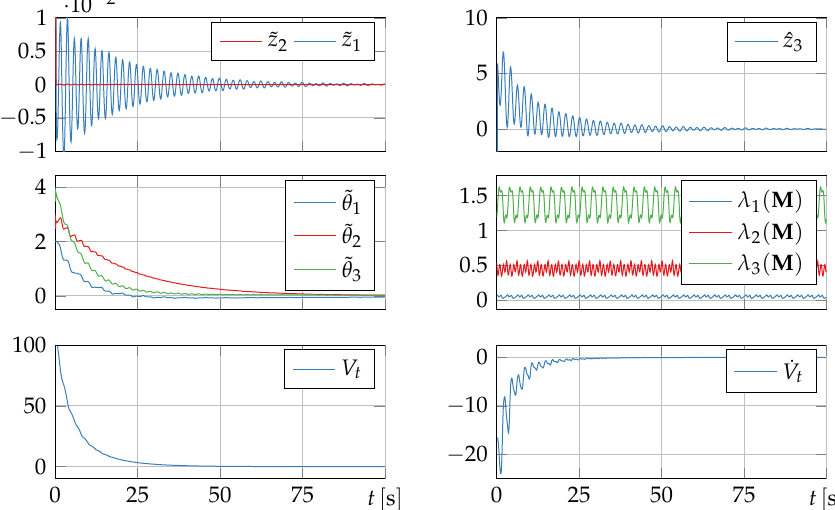
The results of the simulation of PIESO with the regressor dependent only on the time are given in Figure 5. Here, the estimation errors and the total disturbance estimate are shown along with the identification errors, the eigenvalues of the integral M ( t ) and the function V t ( ¯ z , ˜ θ ) with its derivative.